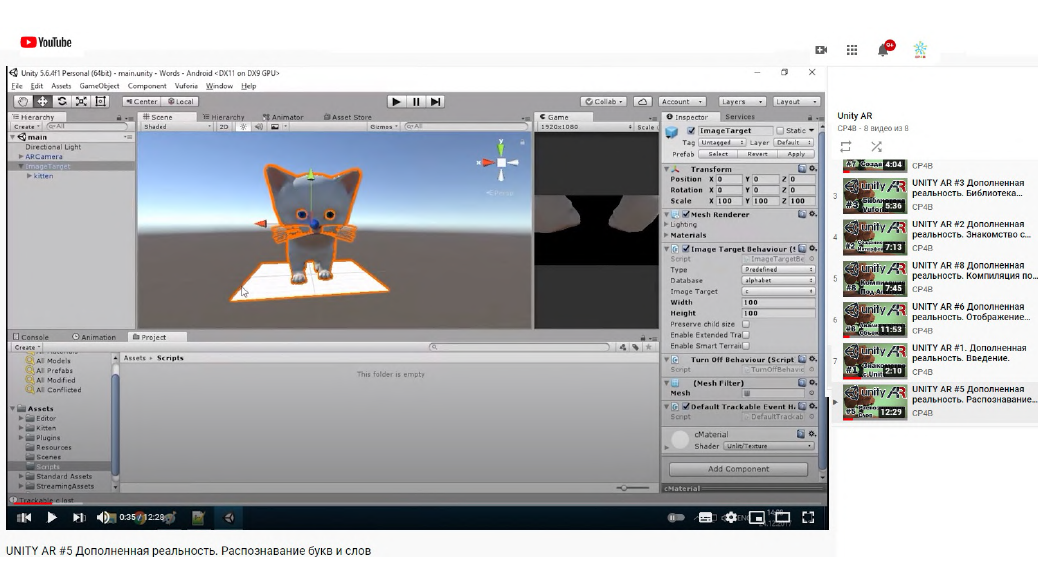
Figure 71: Presentation of paper